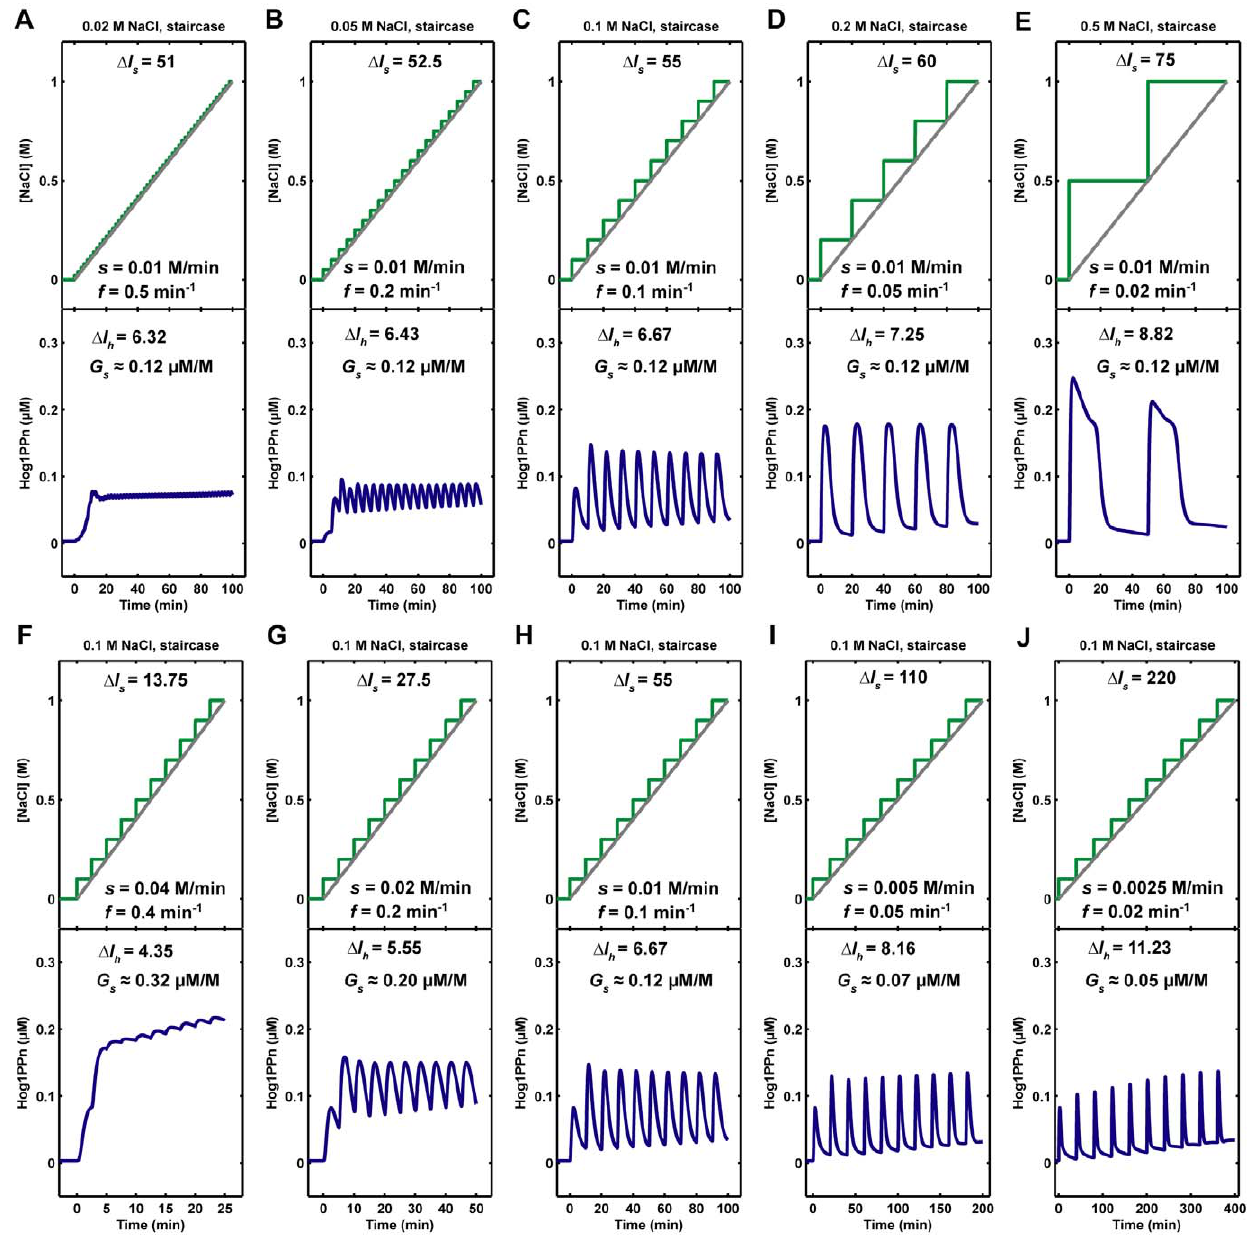
Figure 9. Nuclear phosphorylated Hog1 (Hog1PPn) response to different staircase NaCl stimulations. D I s : NaCl integral change, D I h : integral change of Hog1PPn response, G s : Hog1PPn response gain, s : slope of the staircase profile of NaCl, which is the ratio of final NaCl concentration to the duration of NaCl stimulation. f : frequency of the staircase steps, which corresponds to the inverse of the interval between staircase